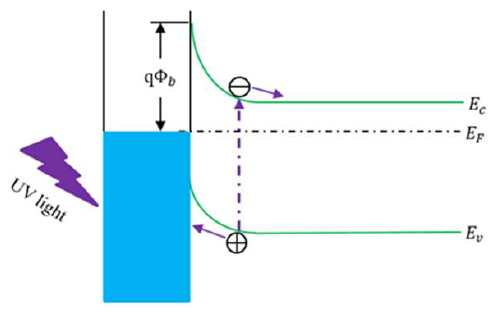
Figure 5. The schematic operation of the mental-( n -type) Schottky photoconductor.